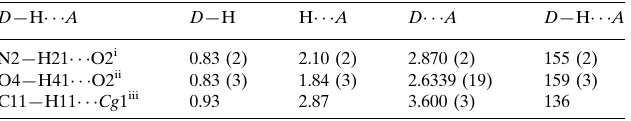
Hydrogen-bond geometry (A˚ , (cid:1)